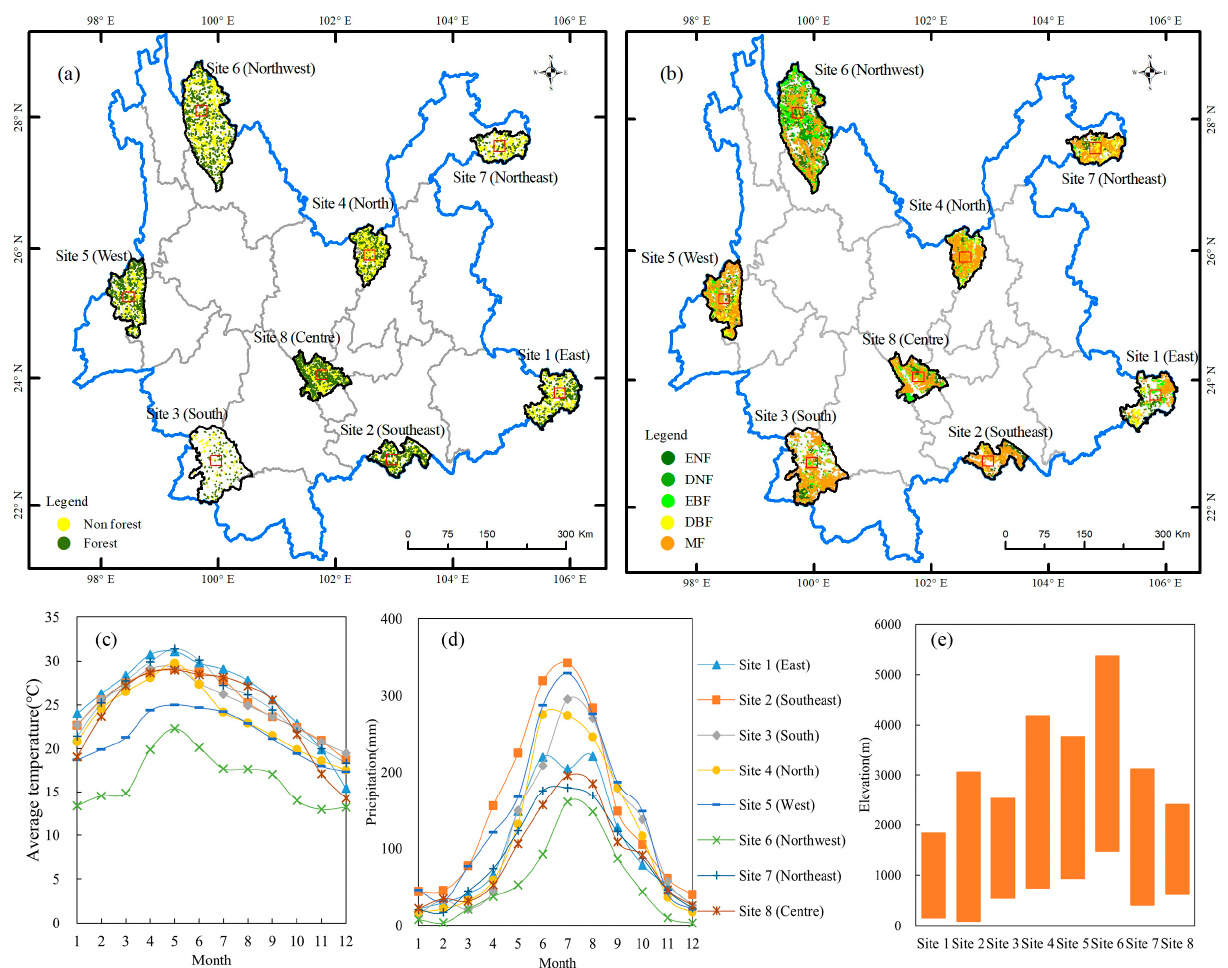
Figure 3. The spatial distribution of samples and the location, temperature, precipitation, and elevation characteristics of eight sites for sample collection. ( a ) 5321 sample plots for the forest/the non-forest are depicted in Section 2.3.2; ( b ) 8701 sample pixels for five forest types are depicted in Section 2.3.2. ENF means evergreen needleleaf forest; DNF means deciduous needleleaf forest; EBF means evergreen broadleaf forest; DBF means deciduous broadleaf forest; MF means mixed forest; ( c ) monthly average temperature; ( d ) monthly average precipitation; ( e ) minimum and maximum altitude. Eight black-border regions are the location of eight administrative counties (cities) for sample collection. Eight red rectangles are the case regions used for